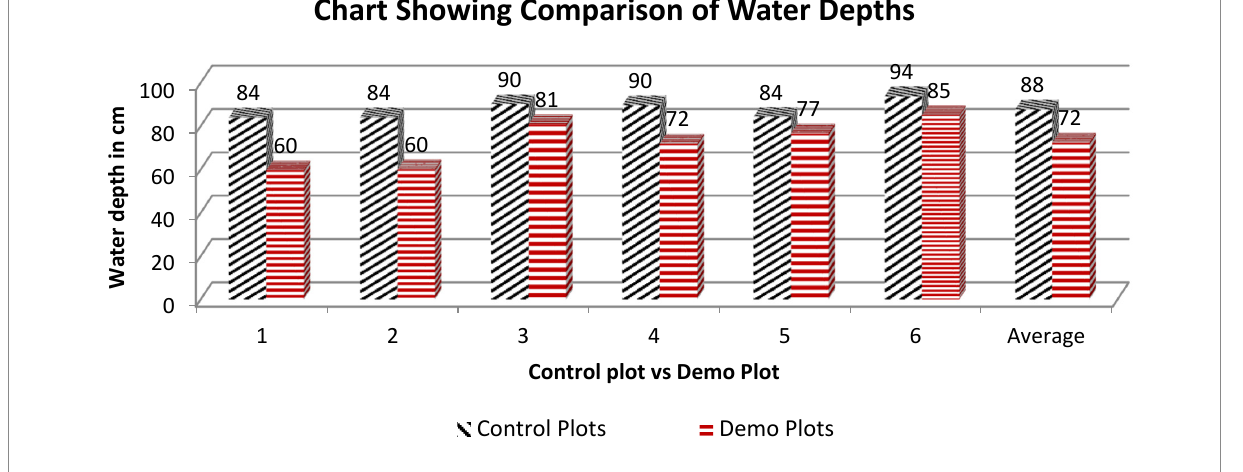
Figure 4. A comparison of irrigation water depths applied in control (where traditional way of irrigation is practiced) and demo (where trench ‐ based irrigation is practiced) plots.